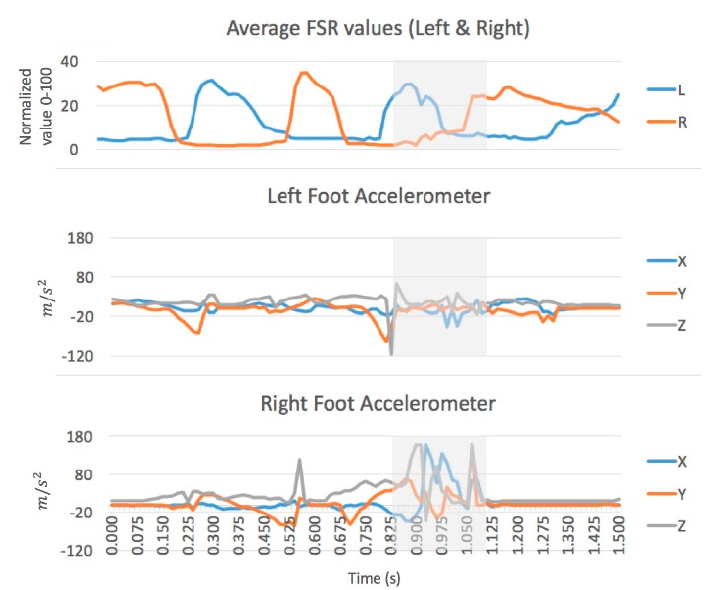
Figure 7. A graph showing FSR values and accelerometer values at the event of kicking a soccer ball. Highlighted area shows high disturbance in the right accelerometer which accurately estimates the time the ball was kicked using the right foot.